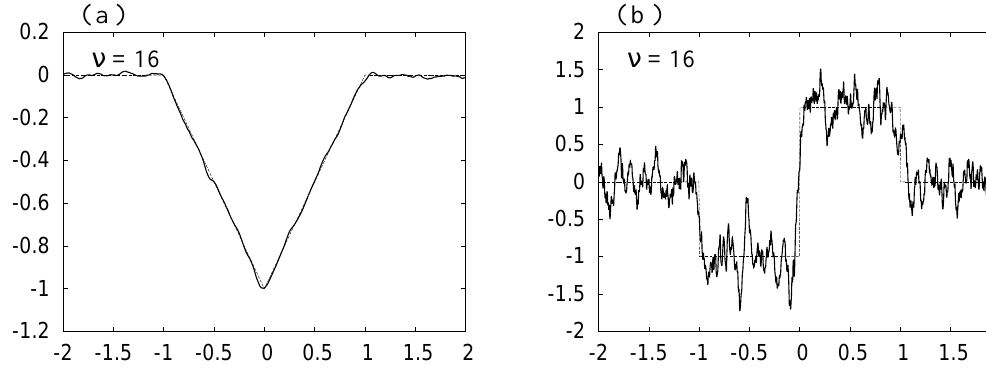
f ( x ) ; ( b ), ( d ), ( f ): ( M ν 1 ,ϵ f ( x ) and ( M ν 1